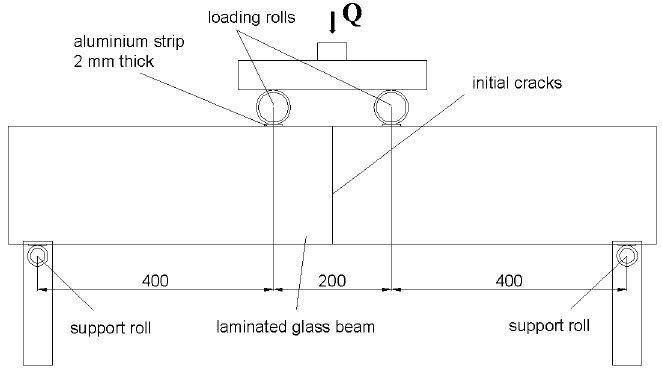
Figure 2: Testing configuration.